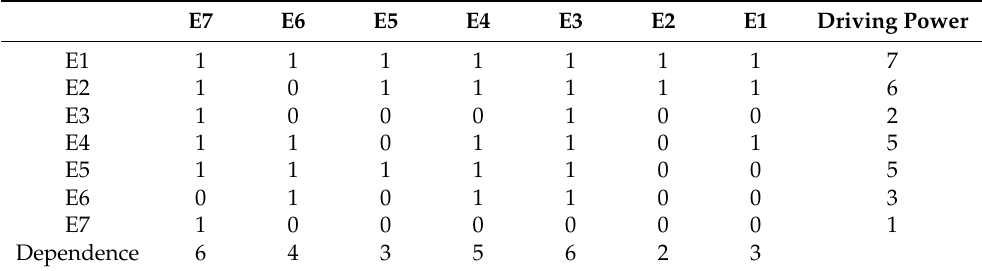
Table 5. The adjacency matrix of